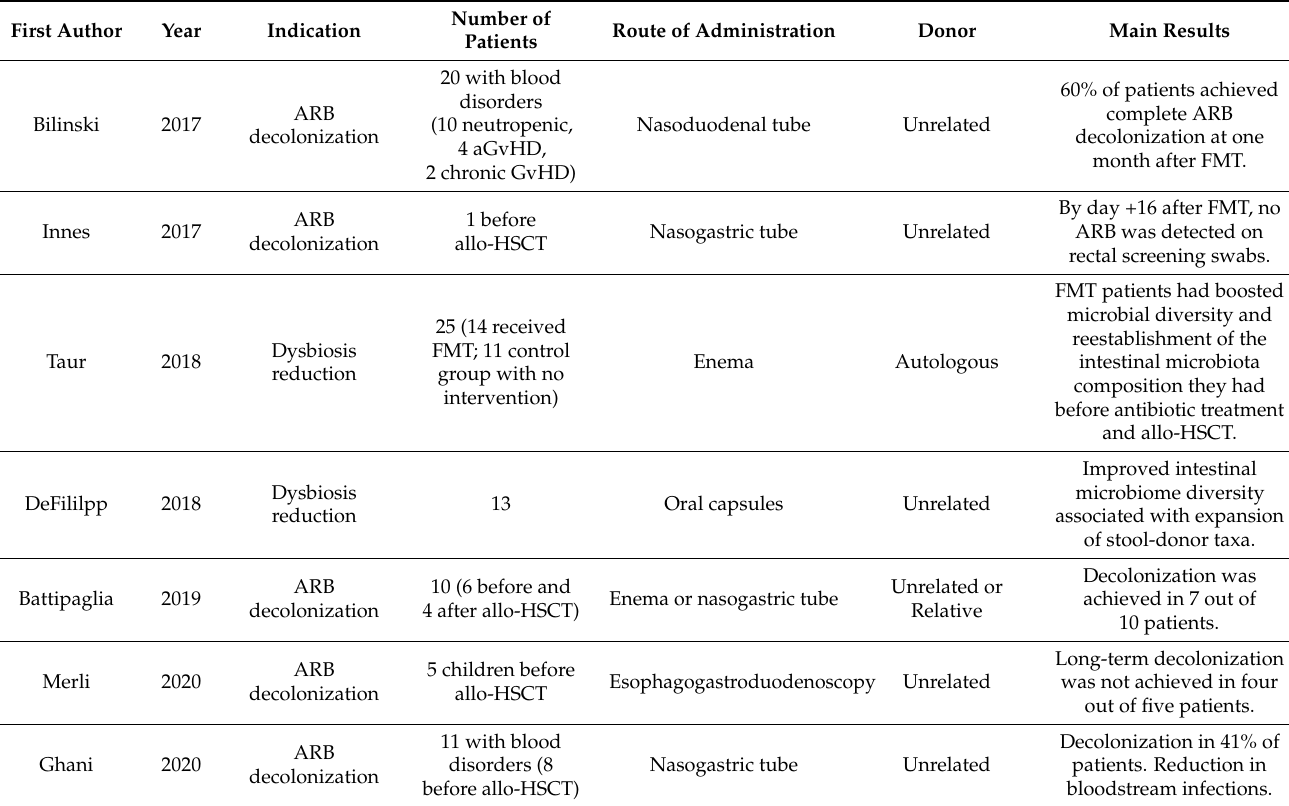
Table 2. Summary of included studies regarding FMT as a preventive strategy in allo-HSCT